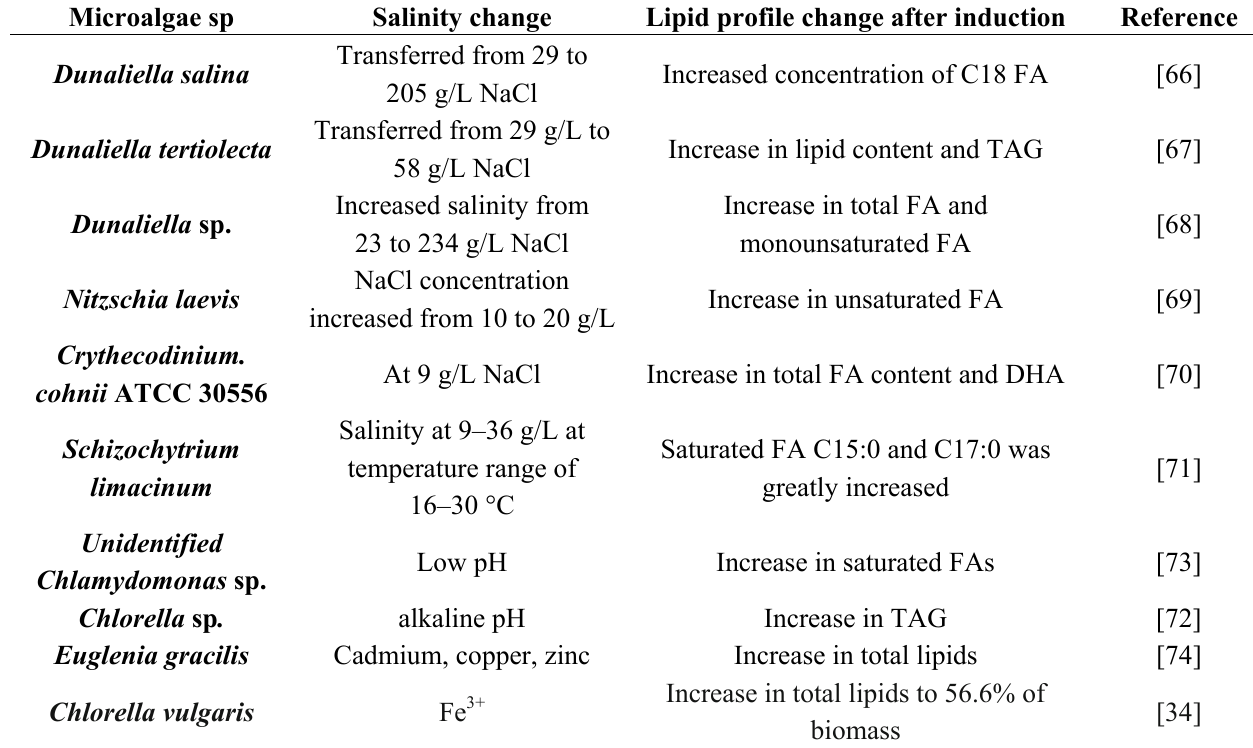
Table 3. Examples of lipid induction in microalgae due to salinity and pH